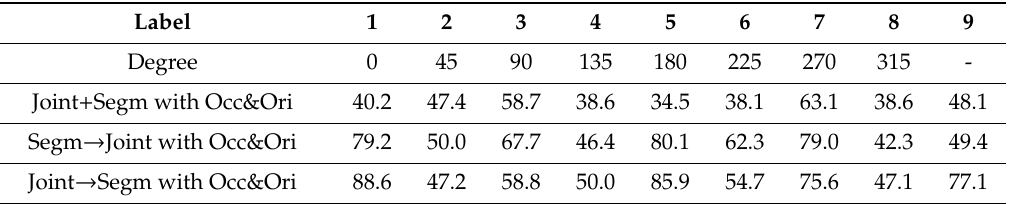
Table 3. Accuracy of orientation recognition in a strict principle (%).